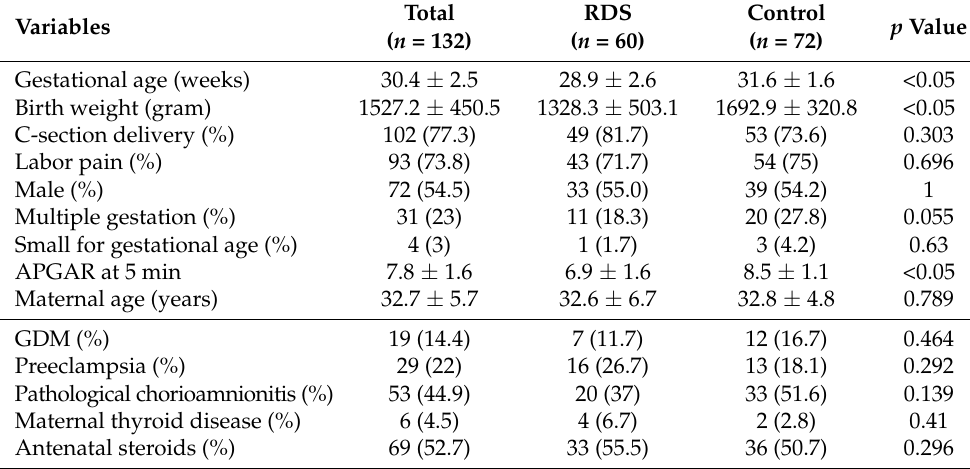
Table 1. Demographics and clinical